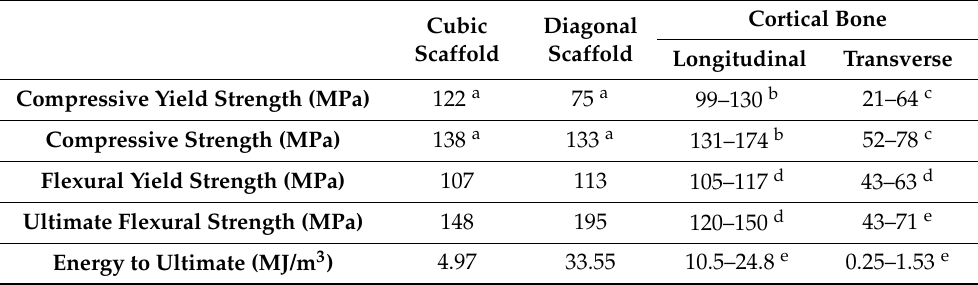
Table 7. Comparison of mechanical strength between bone scaffolds and cortical bone.